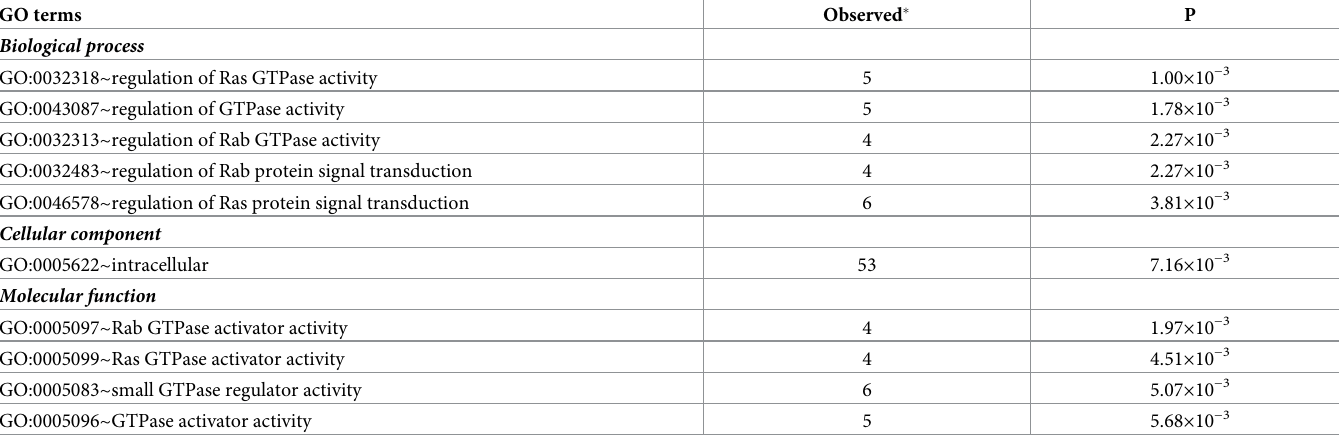
Table 1. Gene Ontology (GO) terms enriched with the targets of bta-mir-122 (P < 0.01). GO terms Observed